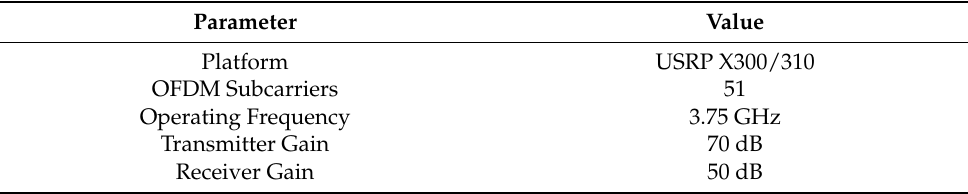
Table 2. Parameter selection and configuration of the